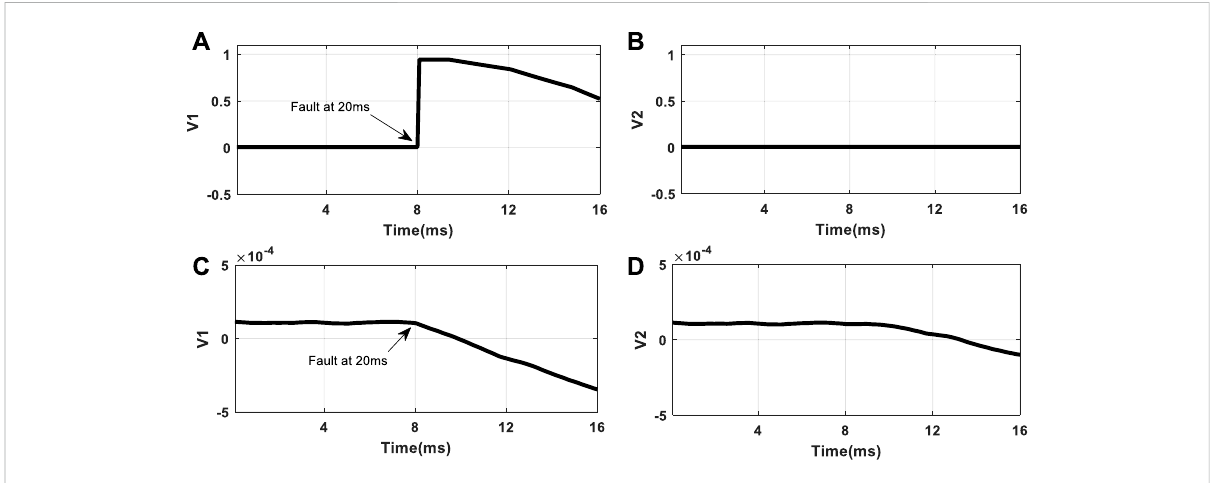
FIGURE 4 (A) Voltage pro fi le of pole 1 during P1G fault at 100 km with R = 0 Ω at 20 ms time. (B) Voltage pro fi le of pole 2 during P1G fault at 100 km with R=0 Ω at20 mstime. (C) Voltagepro fi leofpole1duringtherecti fi erendDCfaultat20 mstime. (D) Voltagepro fi leofpole2duringtherecti fi erfault at 20 ms